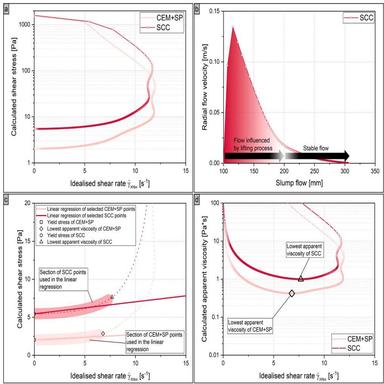
(a) Flow curve of the CEM+SP mix and SCC, with an idealised shear rate based on 30 fps (b) Depiction of flow velocity development during the slump flow process, categorised into zones of influenced flow and stable flow (c) A focused representation of the flow curve involving linear regression (with a fixed intercept at yield stress) of selected measuring points between yield stress and lowest apparent viscosity (d) Viscosity curve of the CEM+SP mix and SCC.